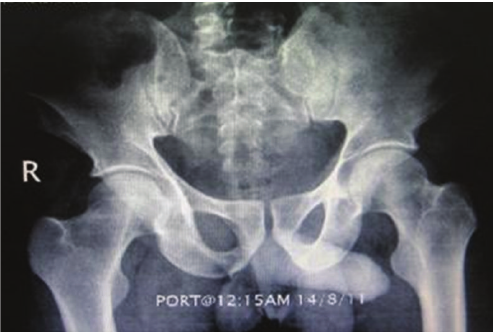
Figure 1: Pelvic X-ray of the patient showing no fracture.